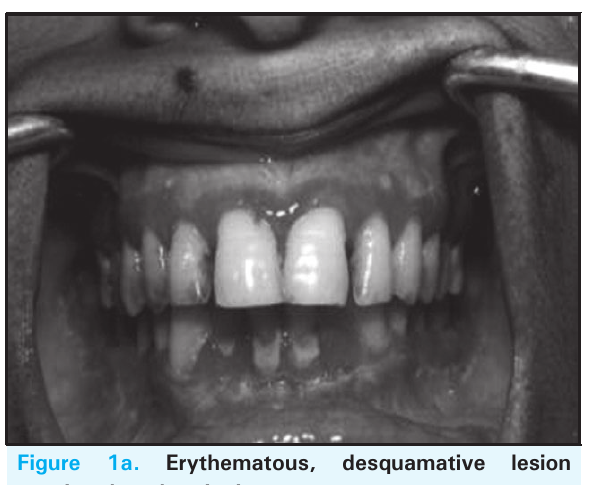
Figure 1a. erythematous, desquamative lesion restricted to the gingiva